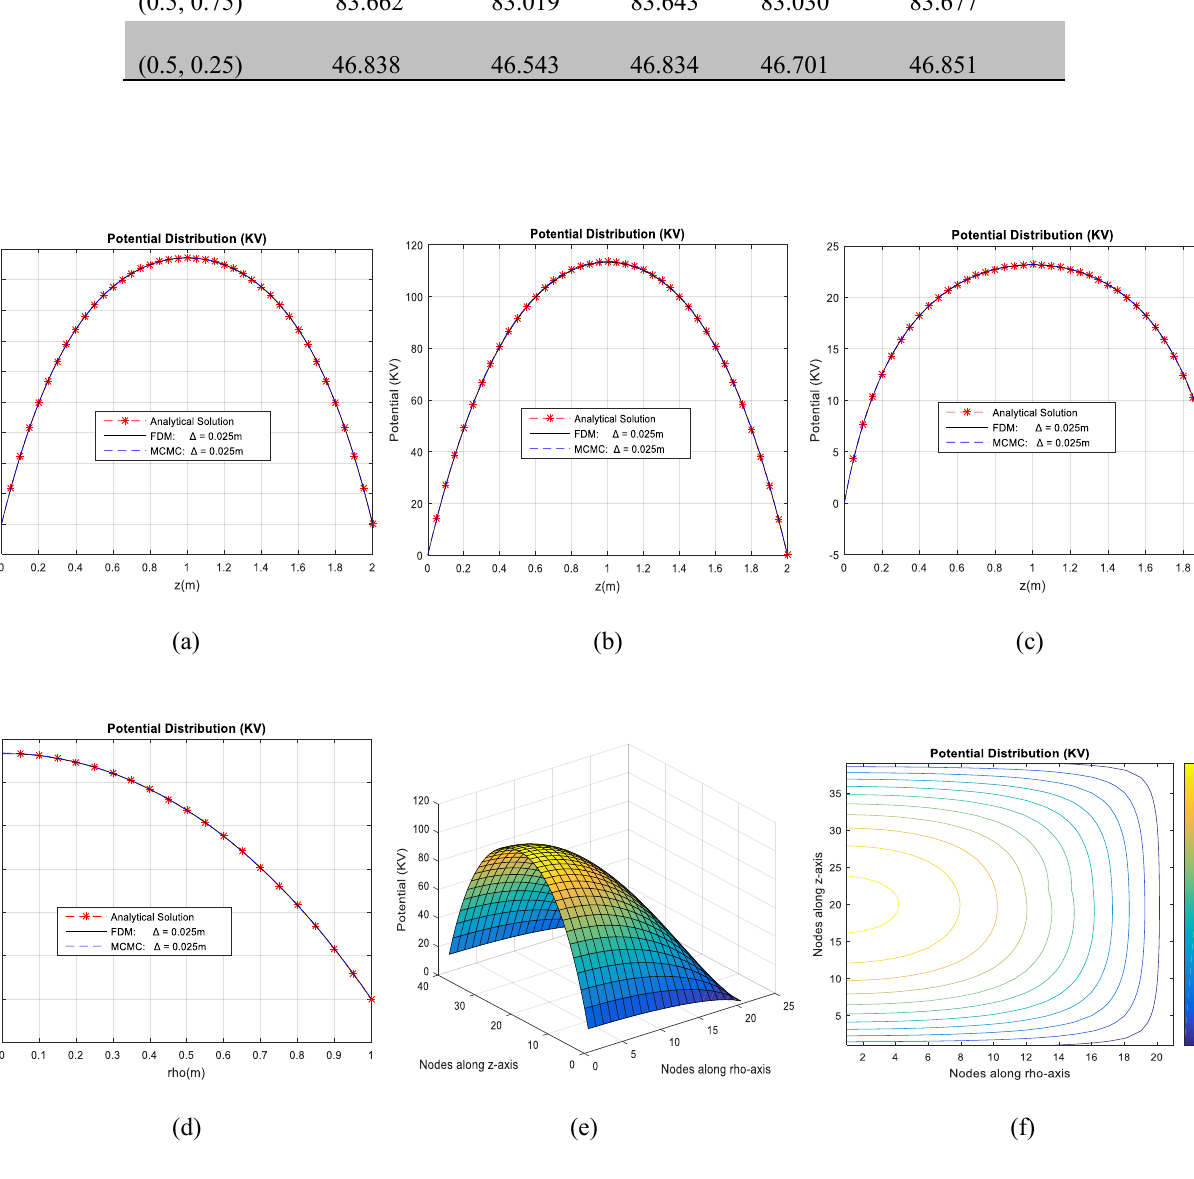
Figure 3. Potential Distribution along (a) (e) Surface plot (f) Contour Plot for Poisson’s equation in Homogeneous Axisymmetric Domain.